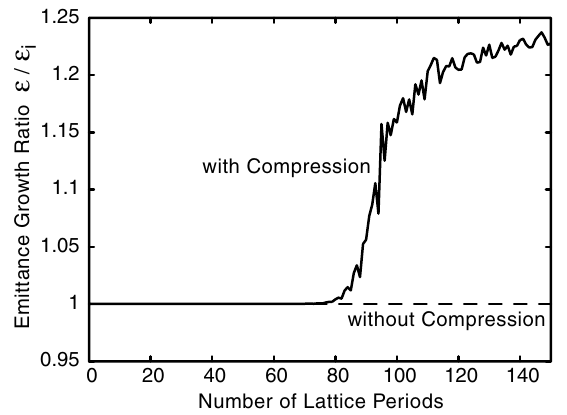
FIG. 4. Evolution of the emittance growth ratio with the initially KV distributed beam. Solid curve shows the emittance growth ratio with the beam current increase due to the longi- tudinal compression, and the dashed line indicates one without the